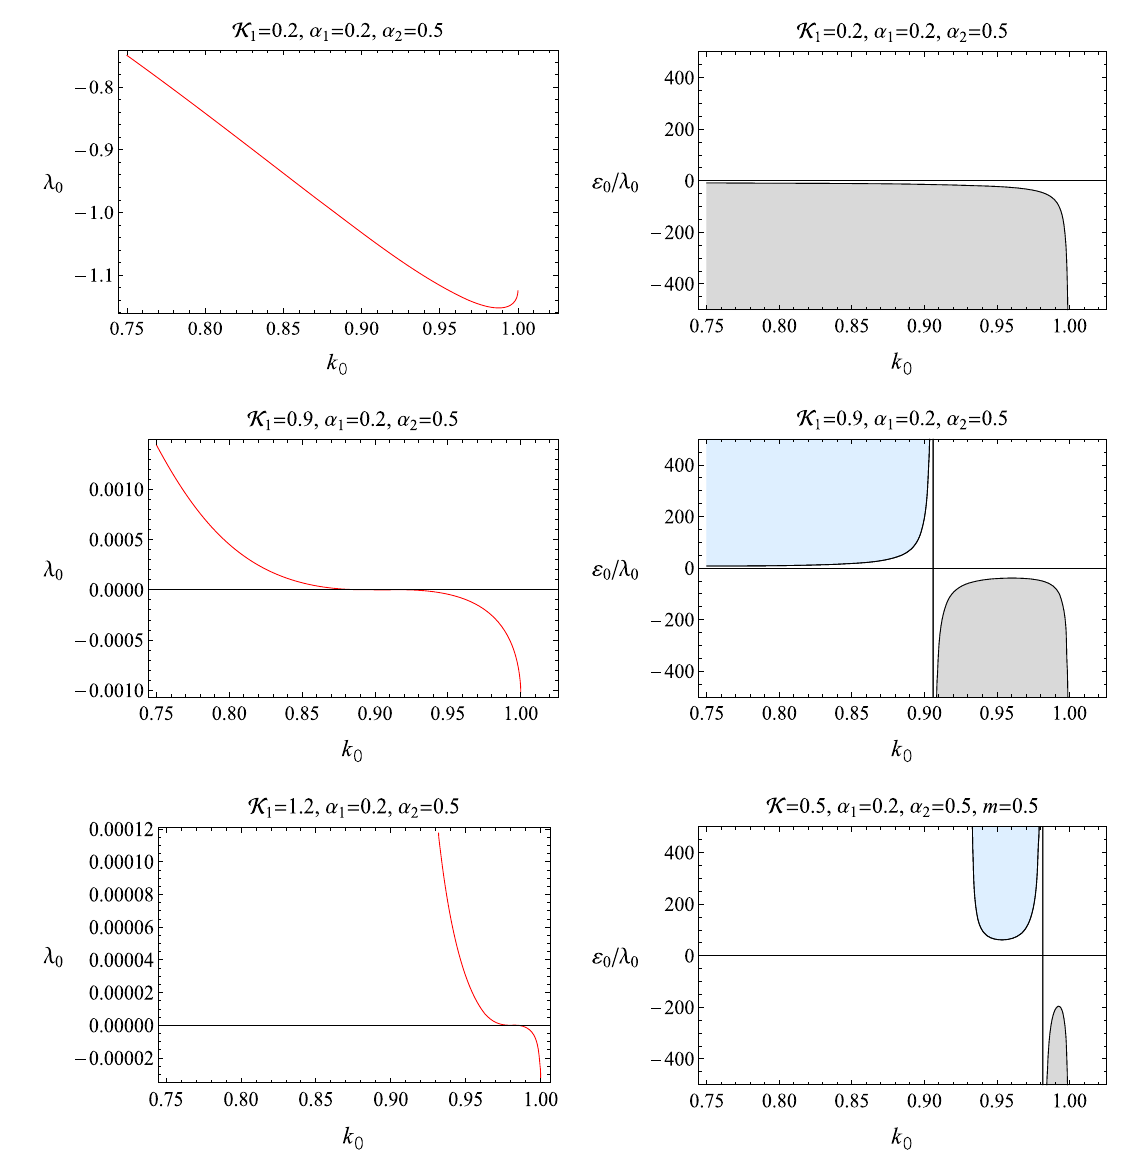
Fig. 9 Stable regions for the choice of first shape function (case(i)) for different values of K 1 . Here, the shaded regions show the stable regions of developed